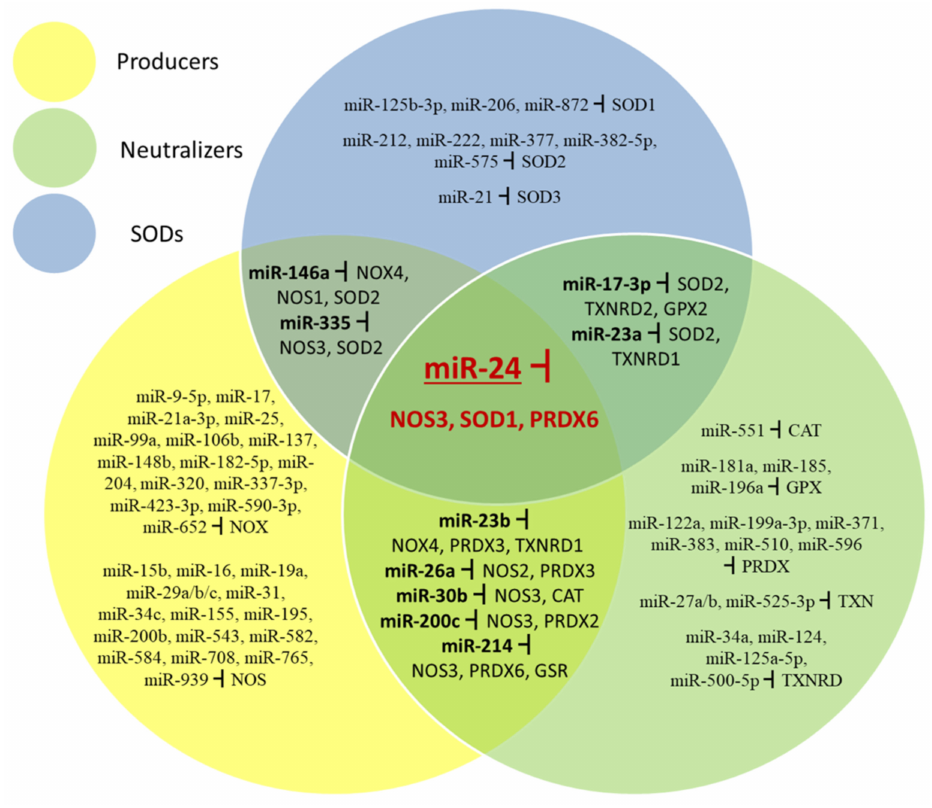
Figure 5. miRNAs which target different parts of the redox control system (ROS-producing, ROS- neutralizing, and SOD